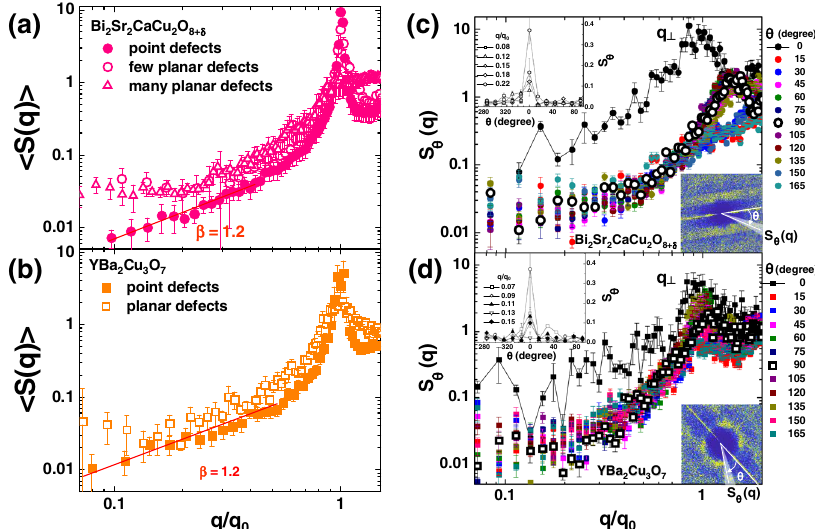
Fig. 3 Evidence supporting the suppression of hyperuniformity in media with planar defects. Angularly-averaged structure factor of the vortex structures nucleated in ( a ) Bi 2 Sr 2 CaCu 2 O 8 + δ and ( b ) YBa 2 Cu 3 O 7 samples with point (full symbols) and planar (open symbols) defects. The wavenumber is normalized by the Bragg wavenumber q 0 = 2 π / a . Full red lines are fi ts to the data in samples with point disorder considering h S ð q Þi (cid:2) ð q = q 0 Þ β when q / q → 0 yielding β = 1.2 ± 0.2. Angular S θ ( q ) structure factor of vortex matter nucleated in ( c ) Bi 0 2 Sr 2 CaCu 2 O 8 + δ and ( d ) YBa 2 Cu 3 O 7 samples with planar defects. Curves obtained averaging the S ( q x , q y ) data shown in the inserts considering ± δθ = 7.5 degree around the azimuthal angles θ indicated in the legends. Black points correspond to S θ = 0 ( q ) in the transversal direction q ⊥ ; white-with-black-edge points show S θ = 90 ( q ) in the longitudinal q ∥ direction; color points correspond to intermediate directions. In the q → 0 limit all curves tend to saturate, but the color and white points form a bunch of data saturating at a smaller value than data for the transversal direction. Left-top inserts: S θ as a function of θ for fi xed values of q / q 0 (vertical cuts of data shown in the main panels). Error bars represent the standard deviation of data when averaging at a given q